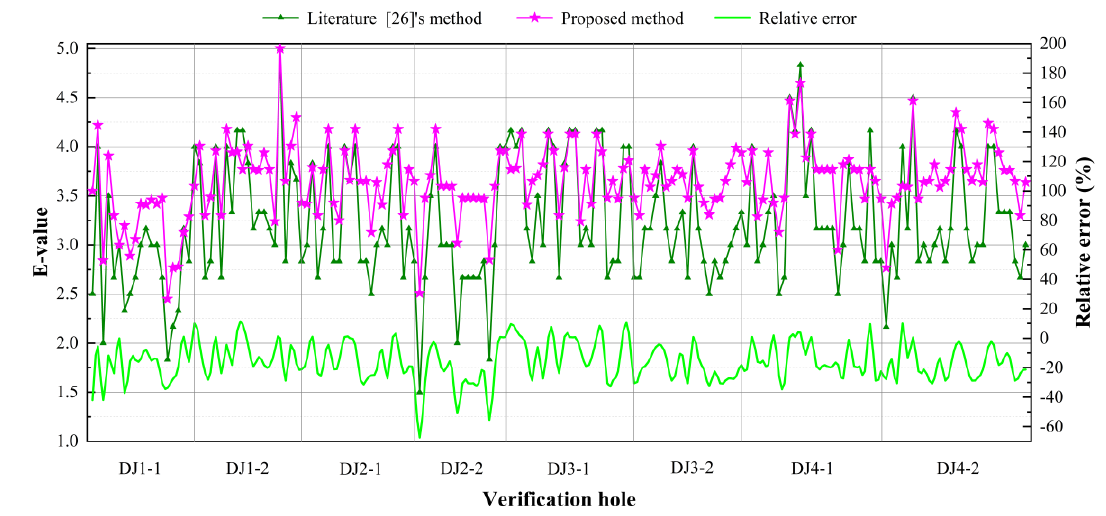
Figure 15. Comparison of the evaluation results in the literature [26] and the proposed method. Note: The calculation equation of relative error is shown in the Appendix A.